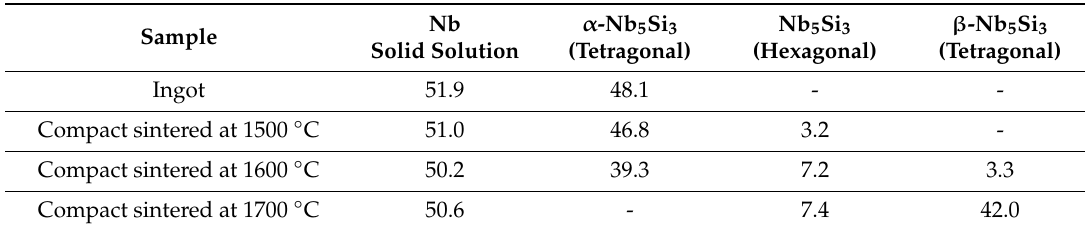
Figure 2. XRD patterns showing crystal structures of samples: the ingot, hydrogenated ingot, and dehydrogenated powders. Table 2. The percentages of phases in the ingot and the compacts sintered at 1500 ◦ C, 1600 ◦ C, and 1700 ◦ C were analyzed using the Rietveld method (wt